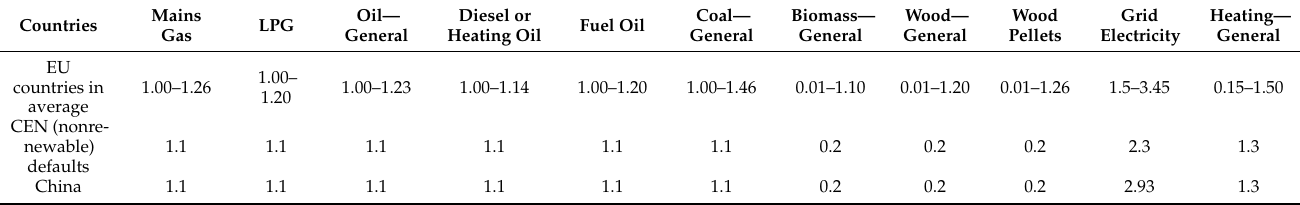
Table 3. Primary energy factors (Acquaye and Duffy, 2010, Climate Transparency,